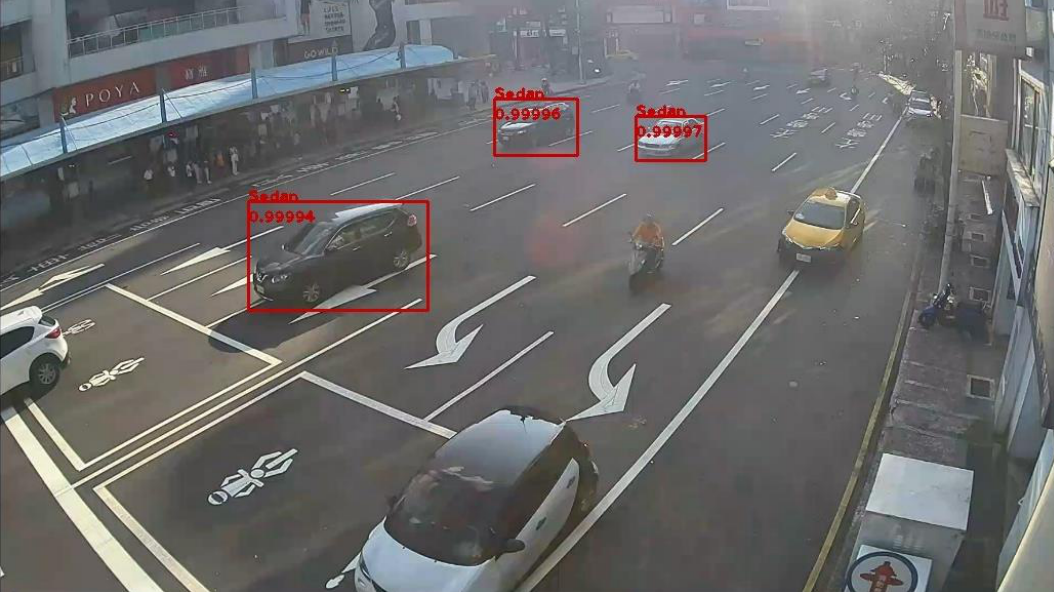
Figure 23. Low-contrast scene image frame detected by YOLOv3.